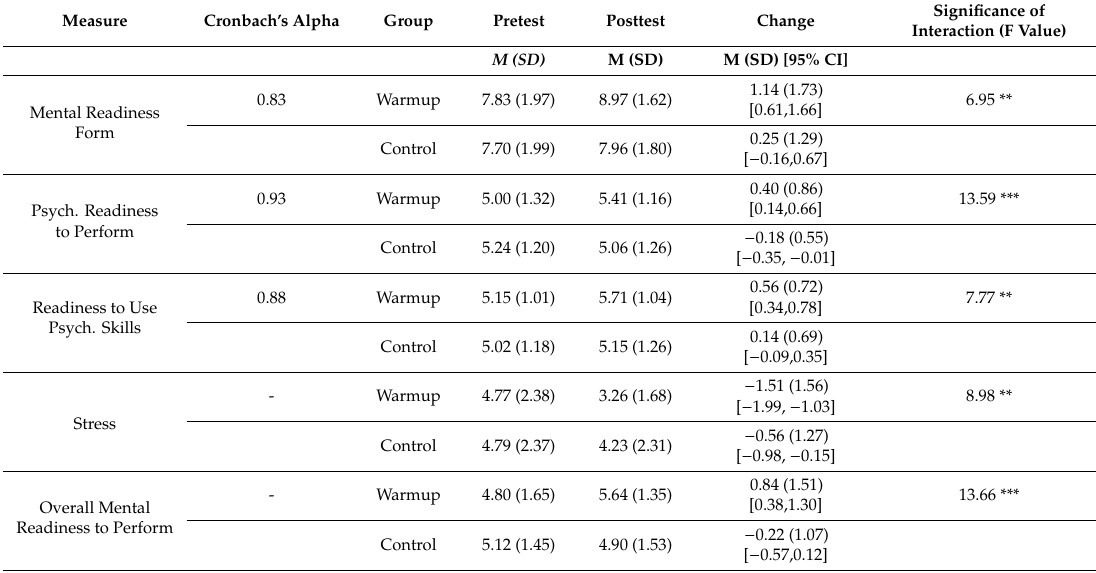
Table 2. Study 2 Descriptive and Inferential Statistics and Measures of Internal